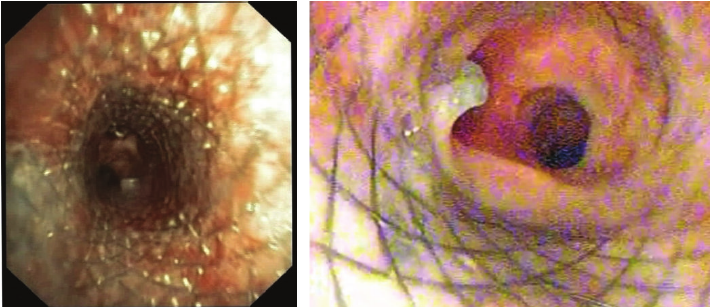
Figure 2: Flexible bronchoscopic image showing that the TEF and the eroded stent have been completely covered by the deployment of a covered tracheal